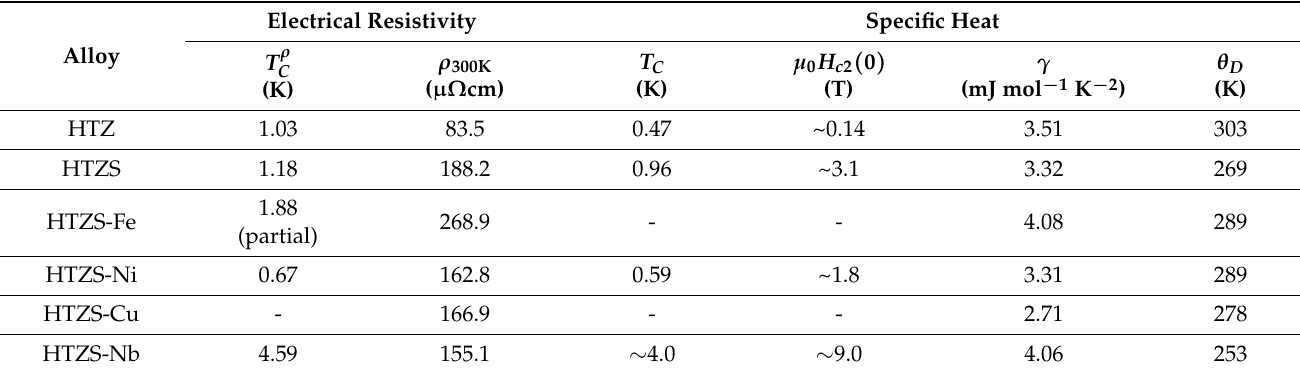
Table 4. Parameters determined from the electrical resistivity (the SC transition temperature T ρ and the specific heat (the SC transition temperature T C , the upper critical field µ 0 H c 2 ( 0 ) , the electronic specific heat coefficient γ and the Debye temperature θ D ) for the investigated alloys.